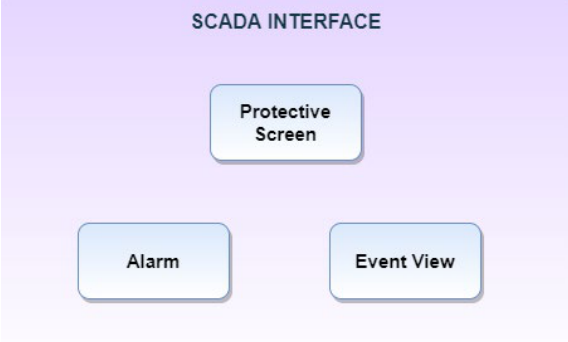
Fig. 5. Home screen for SCADA